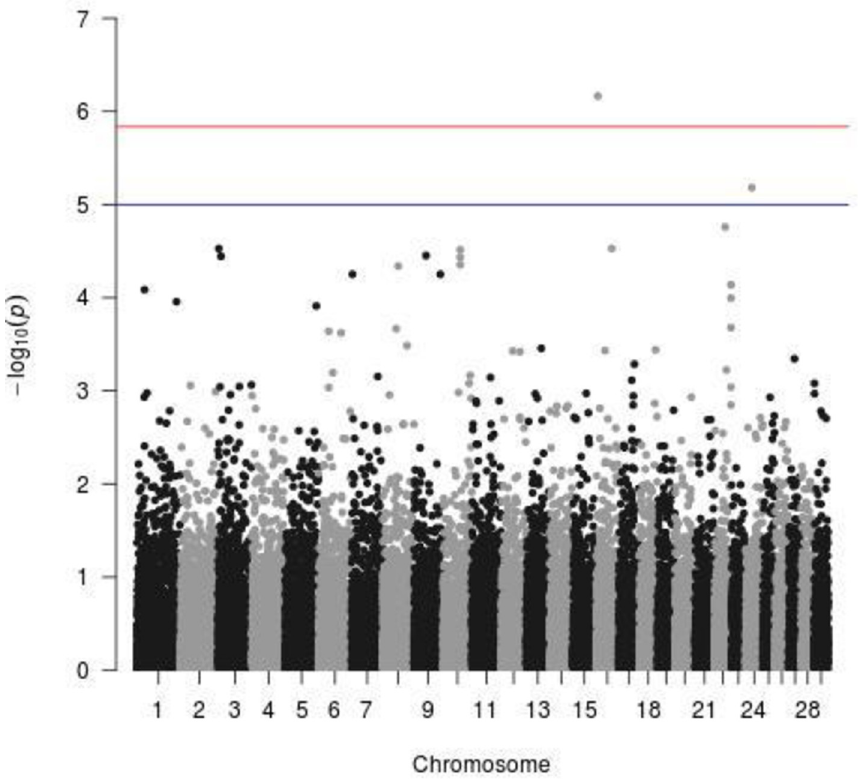
Fig 3. Significant SNPs related to resistance against trypanosomiasis in the purebred Baoule´ cattle (blue line = indicative threshold–log10(p) = 5; red line = Bonferroni threshold–log10(p) = 5.86).